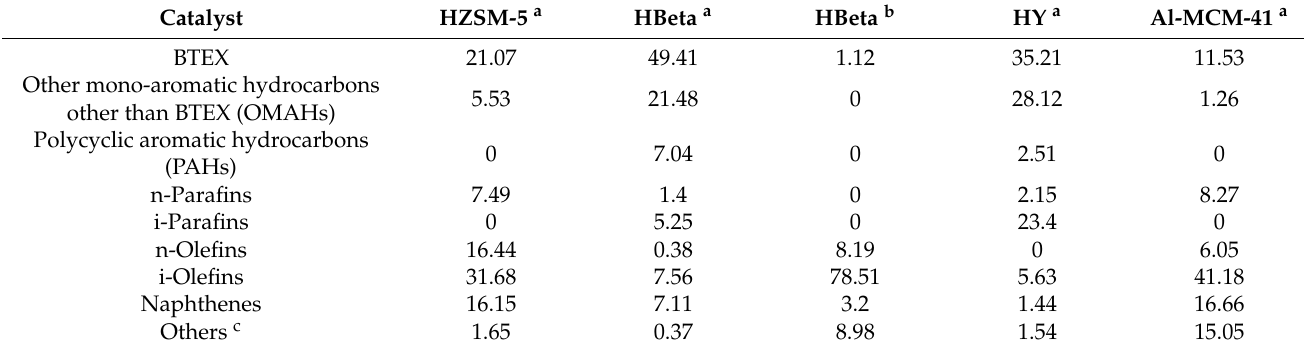
Table 2. Compositions of liquid products from mask pyrolysis over various zeolite catalysts. Repro- duced with permission from Ref. [64]. Copyright 2021 Elsevier